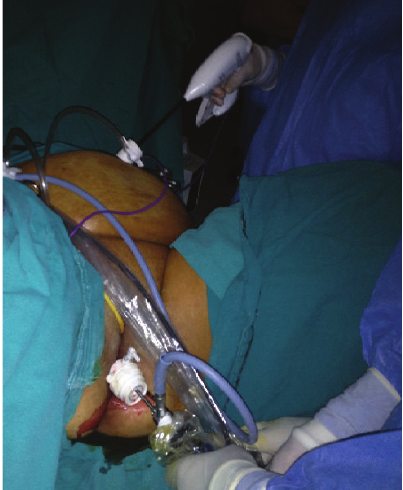
Figure 3: Division of mesoappendix through the umbilical port by Ligasure (5mm).